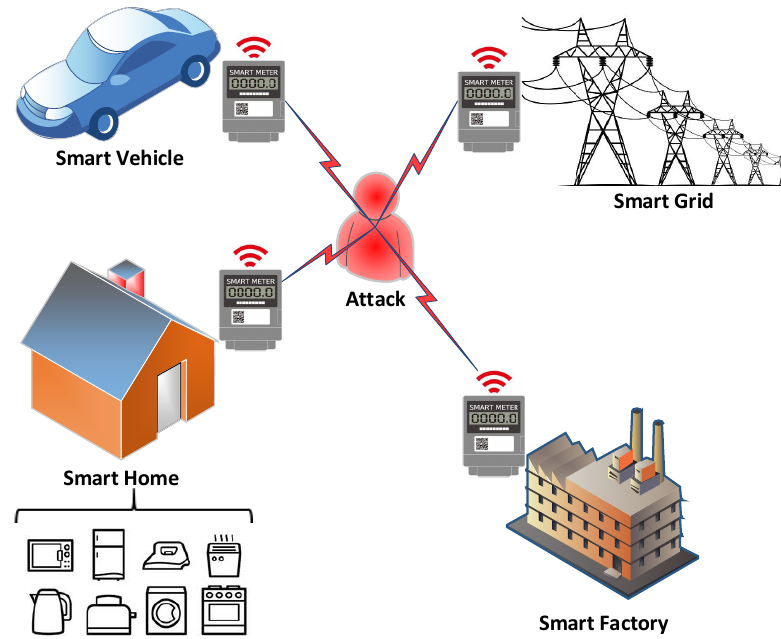
Figure 1. Framework of smart meter applications with attack